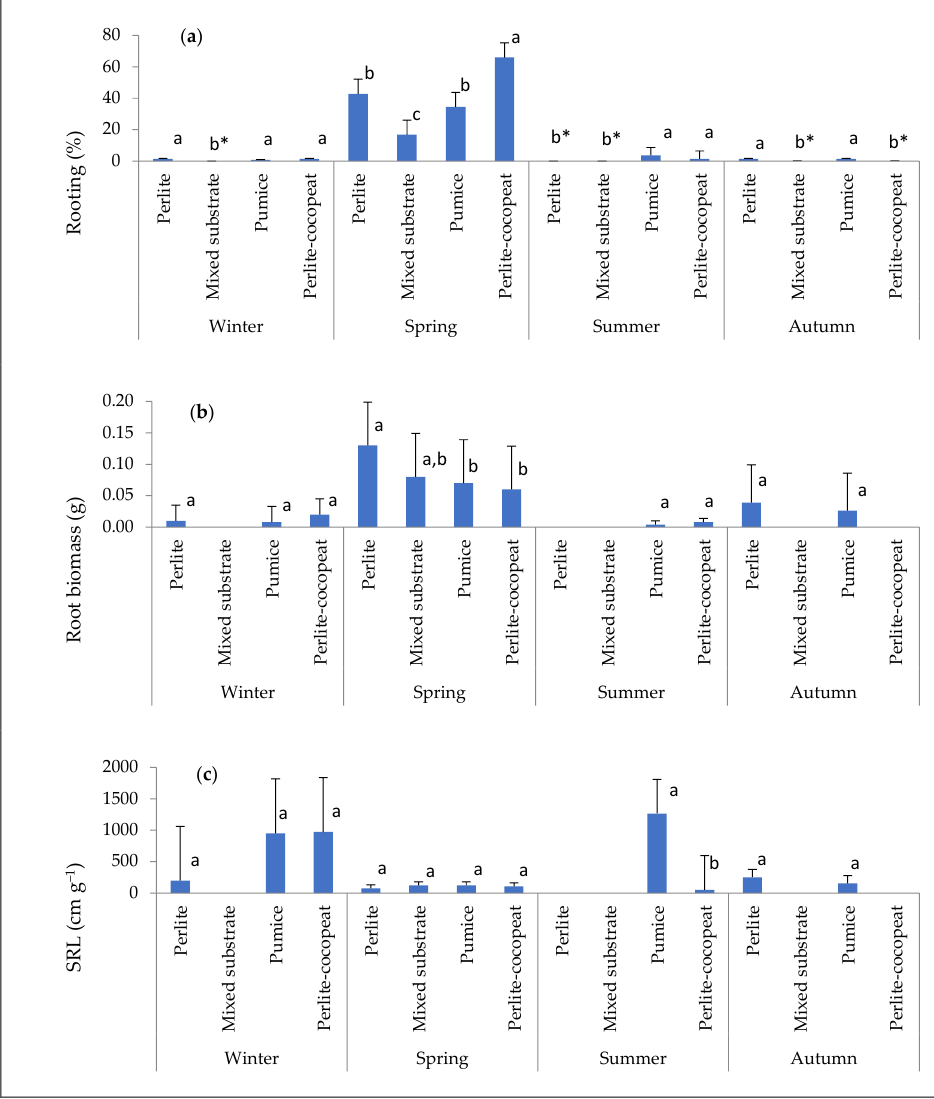
Figure 5. Mean values of rooting performance of rooted cuttings within seasons and with four substrates analyzed: ( a ) % of rooting, ( b ) root biomass, and ( c ) SRL. Mean values with the same letter do not differ at 0.05 level according to LSD test. Sample data = 540 cuttings in each season. Error bars: LSD intervals. *Rooting percentage was zero.